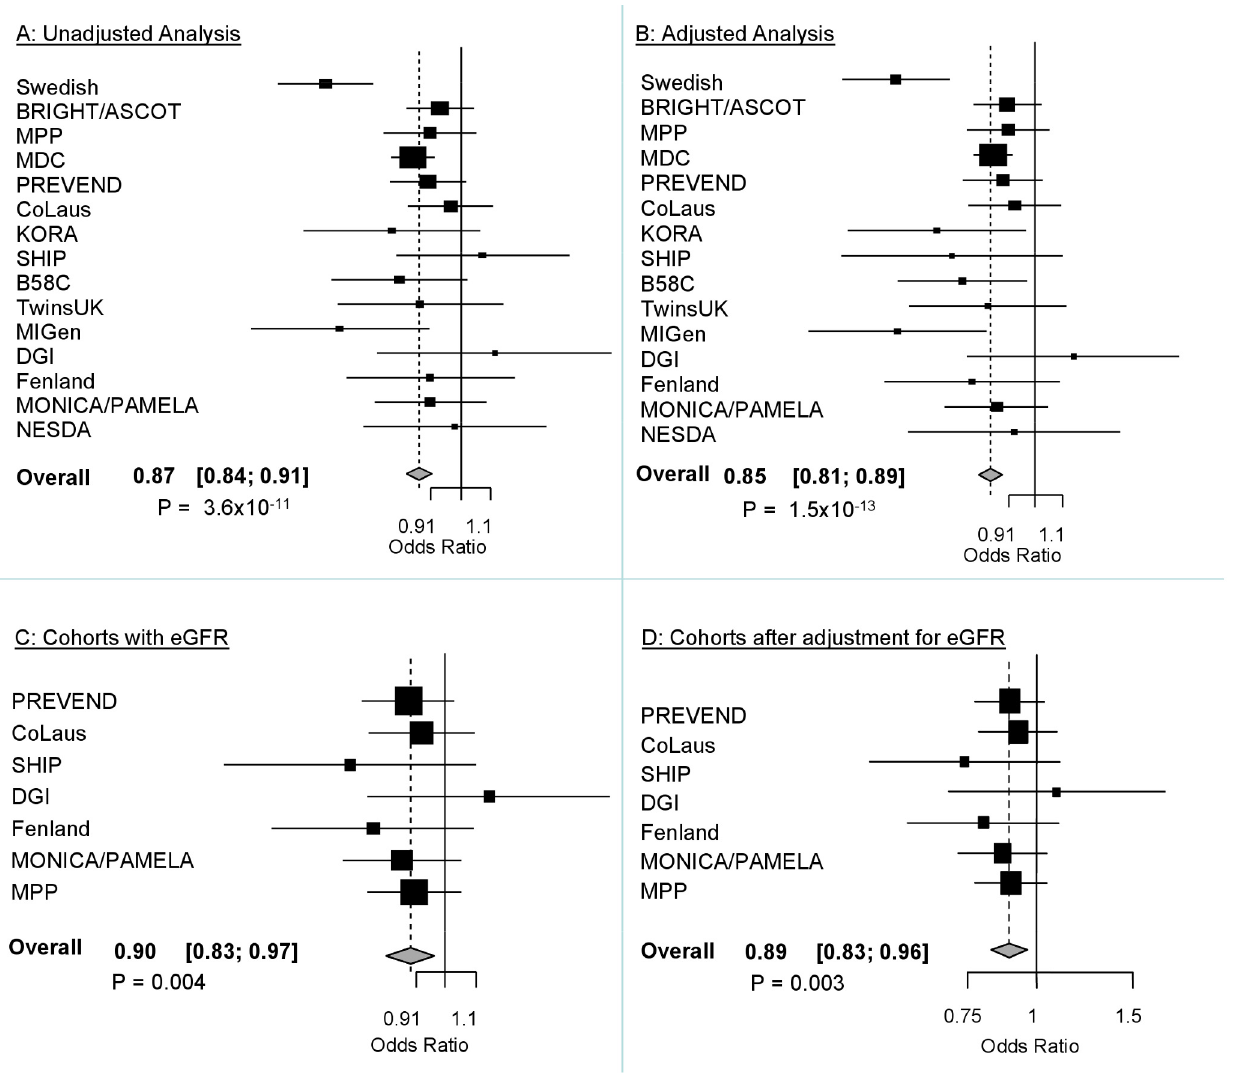
Figure 4. Forest Plots of association with rs13333226 and hypertension (adjustment for population stratification was applied using principal components as appropriate for each cohort). A: Forest plot of association analysis unadjusted for any covariates 2 21,466 cases and 18,240 controls. B: Forest plot of association analysis adjusted age, age 2 , sex and BMI 2 21,466 cases and 18,240 controls. C: Forest plot of association analysis in the cohorts where eGFR was available and adjusted for age, age 2 , sex, BMI 2 7427 controls and 5739 cases. D: Forest plot of association analysis in the cohorts where eGFR was available and adjusted for age, age 2 , sex, BMI and eGFR 2 7427 controls and 5739 cases.